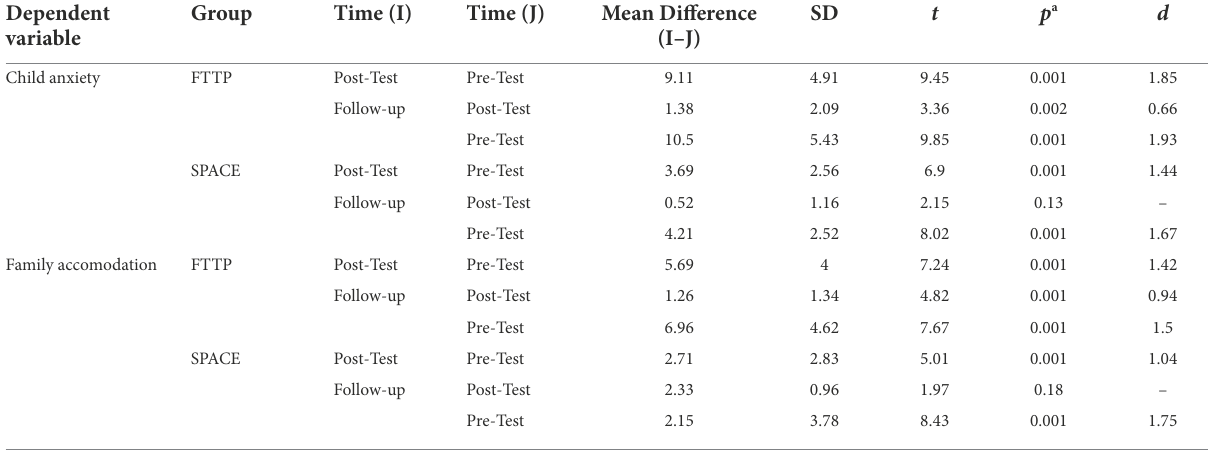
TABLE 8 Paired samples t -tests to make post hoc comparisons between three assessment scores across groups.